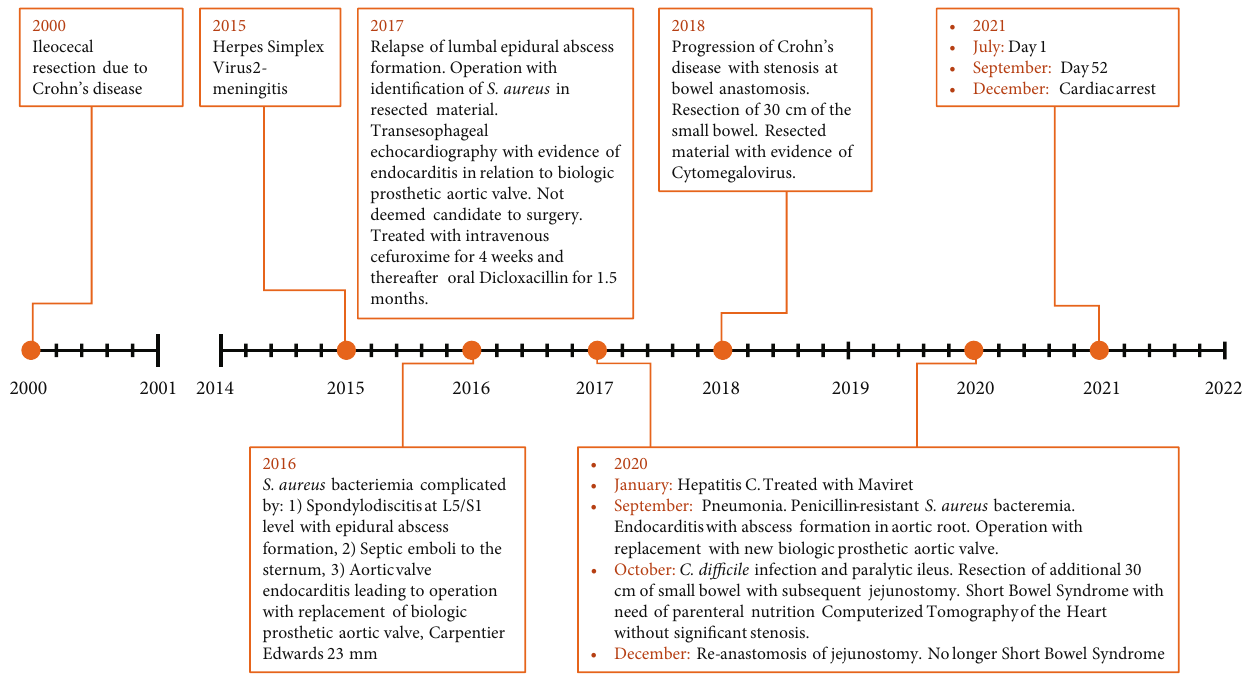
Figure 1: Timeline (see text for further